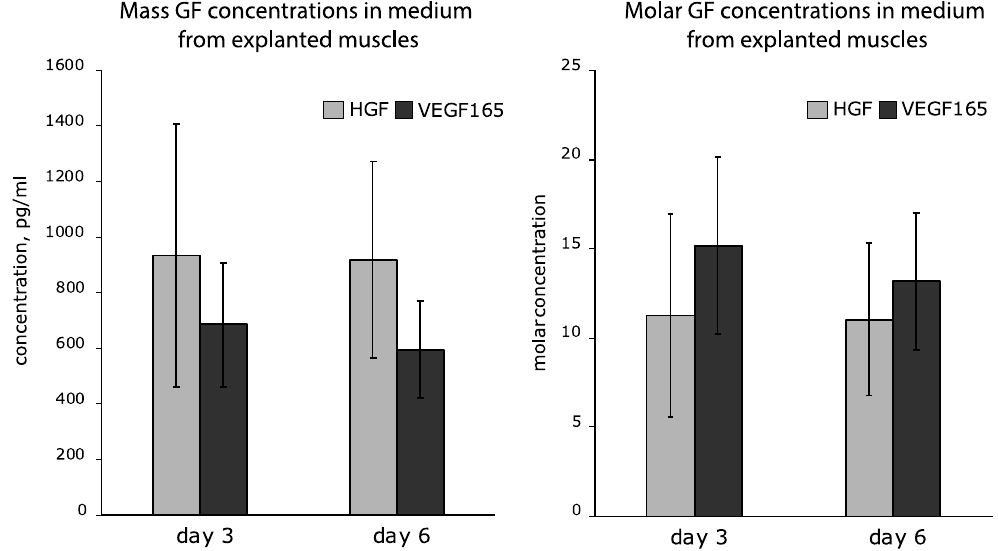
Figure 5. Relative caspase-3 / 7 activity in HUVECs visualized using a specific fluorescent substrate. Relative caspase-3 / 7 activity was determined by the following formula: caspase-3 / 7 dye sum area (green) / cells sum area. Data are presented as mean ± SEM. Scale bar represents 100 µ m.